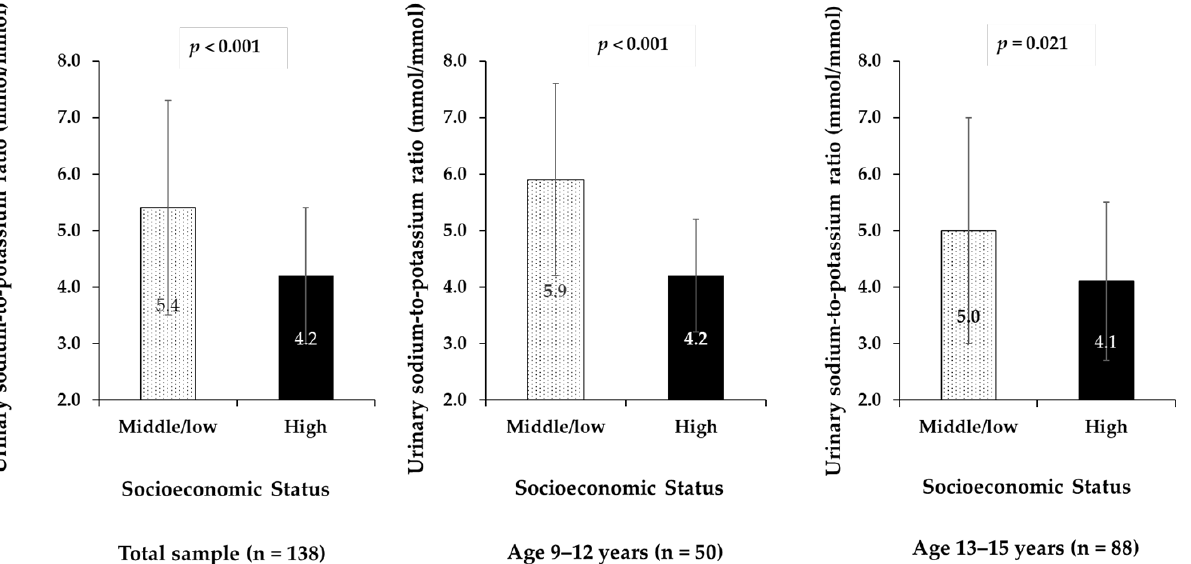
Figure 1. Differences in the urinary sodium-to-potassium ratio by socioeconomic status. To compare the difference in the mean urinary Na/K ratio based on socioeconomic status, one-way analysis of variance was conducted. The socioeconomic status was assessed using the parental educational status, which was classified as follows: low, 11 years or below; middle; 12–15 years; and high, 16 years or more.